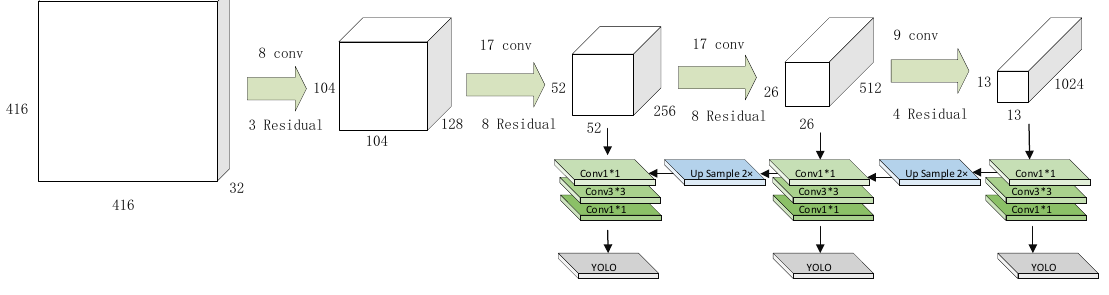
Figure 1. Original YOLOV3 network